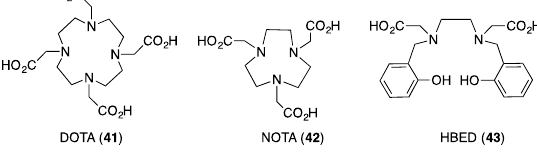
Figure 9. Chelators for 68 Ga 3+ .